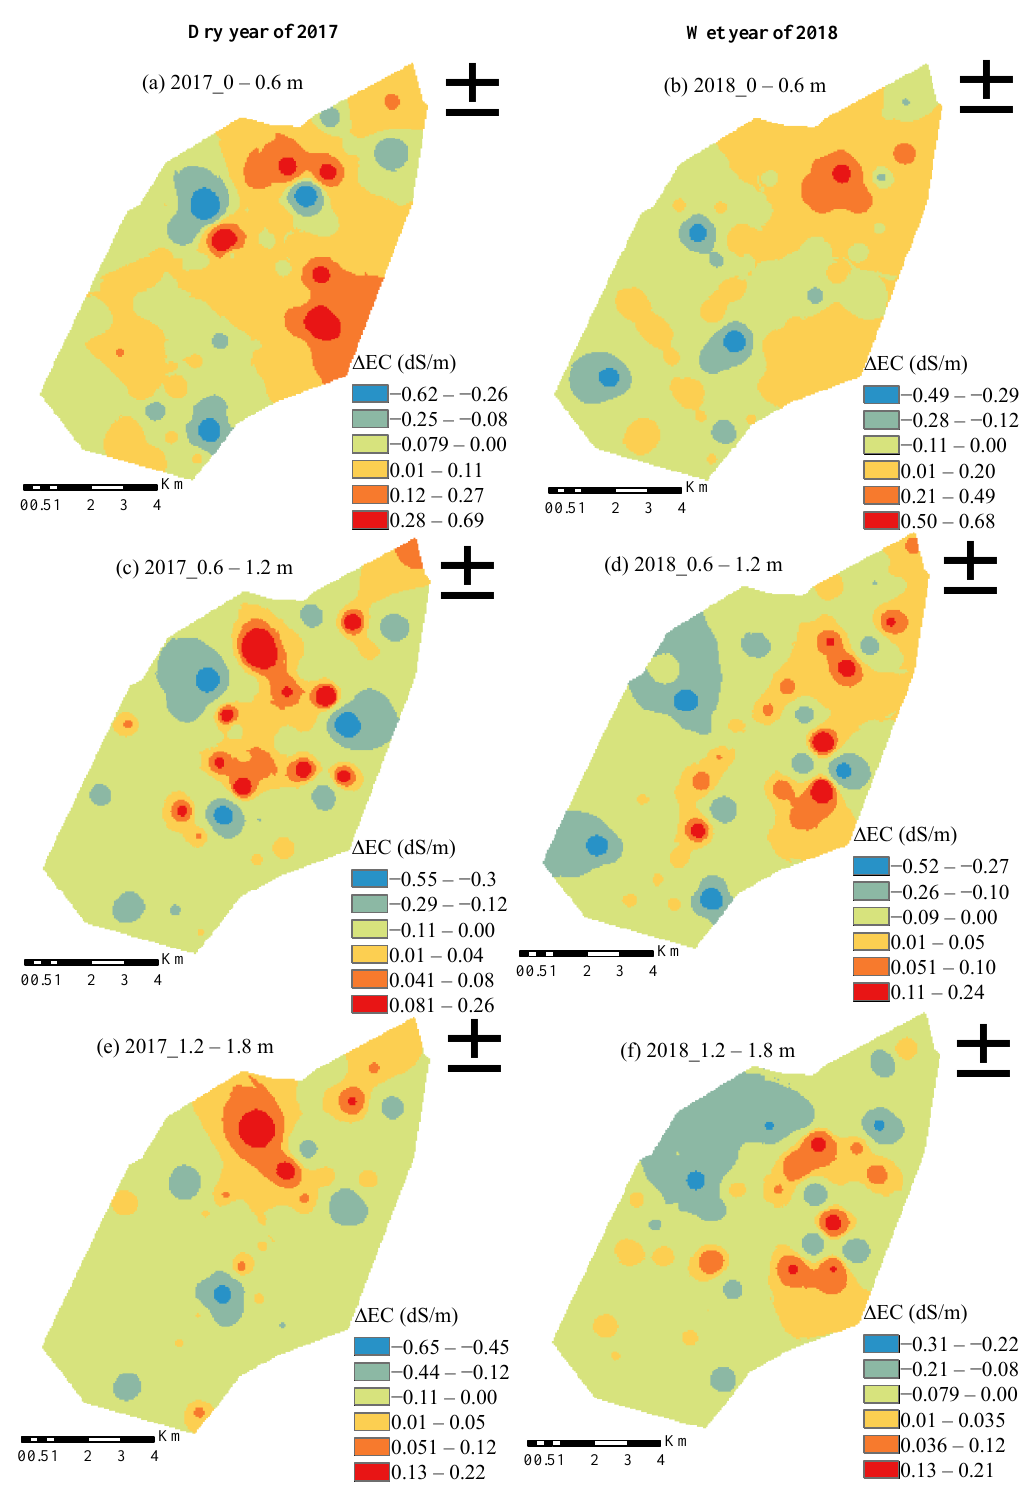
Figure 4. Spatial distribution of soil salinity increment at depths of 0 – 0.6 m, 0.6 – 1.2 m, and 1.2 – 1.8 m in the crop growing season during the dry year of 2017 and wet year of 2018.